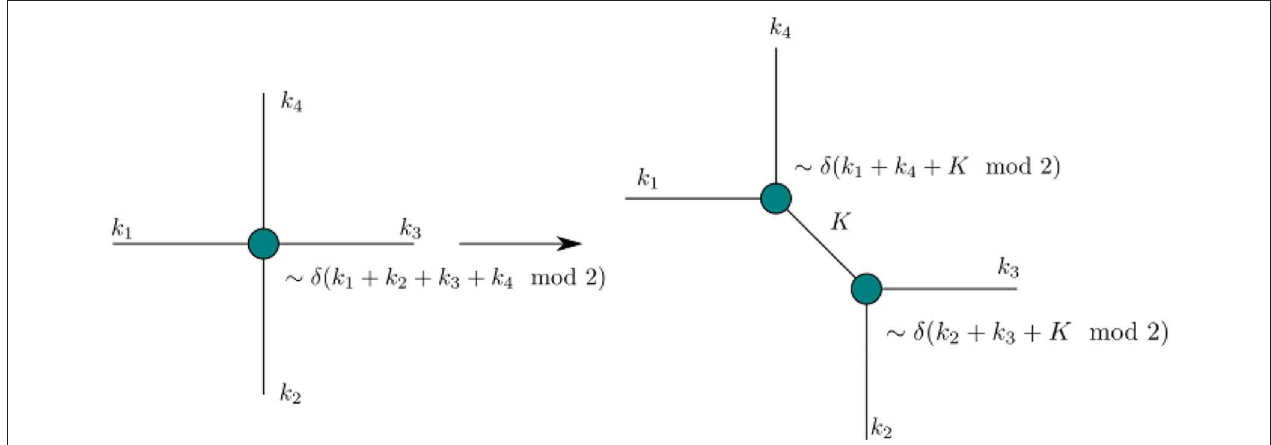
FIGURE 10 | By explicitly preserving the symmetry of the tensor, we assign an irreducible representation to the new effective edge, thus preserving also the original theory space. Here shown for the Z 2 /Ising model case.